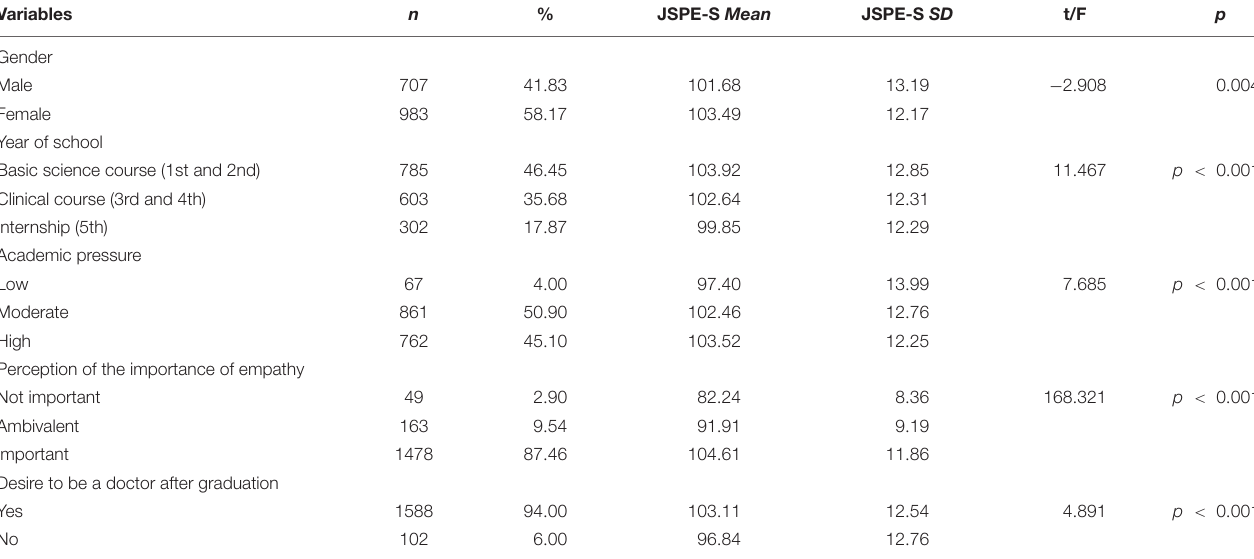
TABLE 2 | Comparison of the level of empathy among groups with different personal and academic variables. Variables